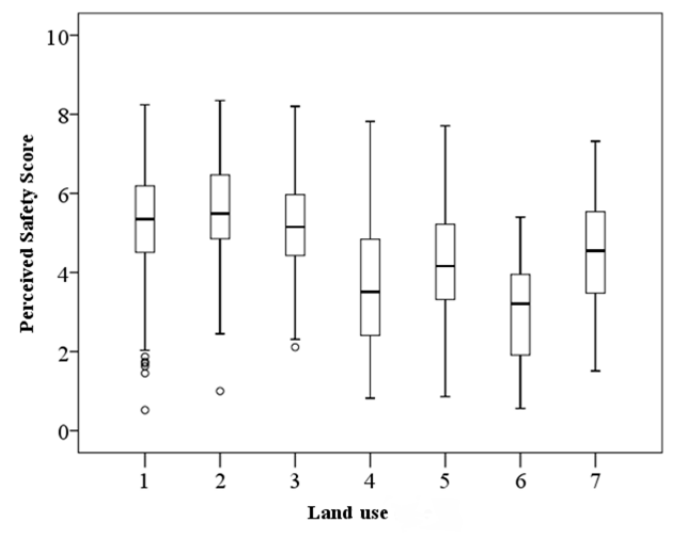
Figure 6. The box plot of the perceived safety scores for different land use types (1 denotes multifamily residential land, 2 denotes high density residential land, 3 denotes urban public/institutional land, 4 denotes transportation, 5 denotes commercial land, 6 denotes industrial land, 7 denotes open land).